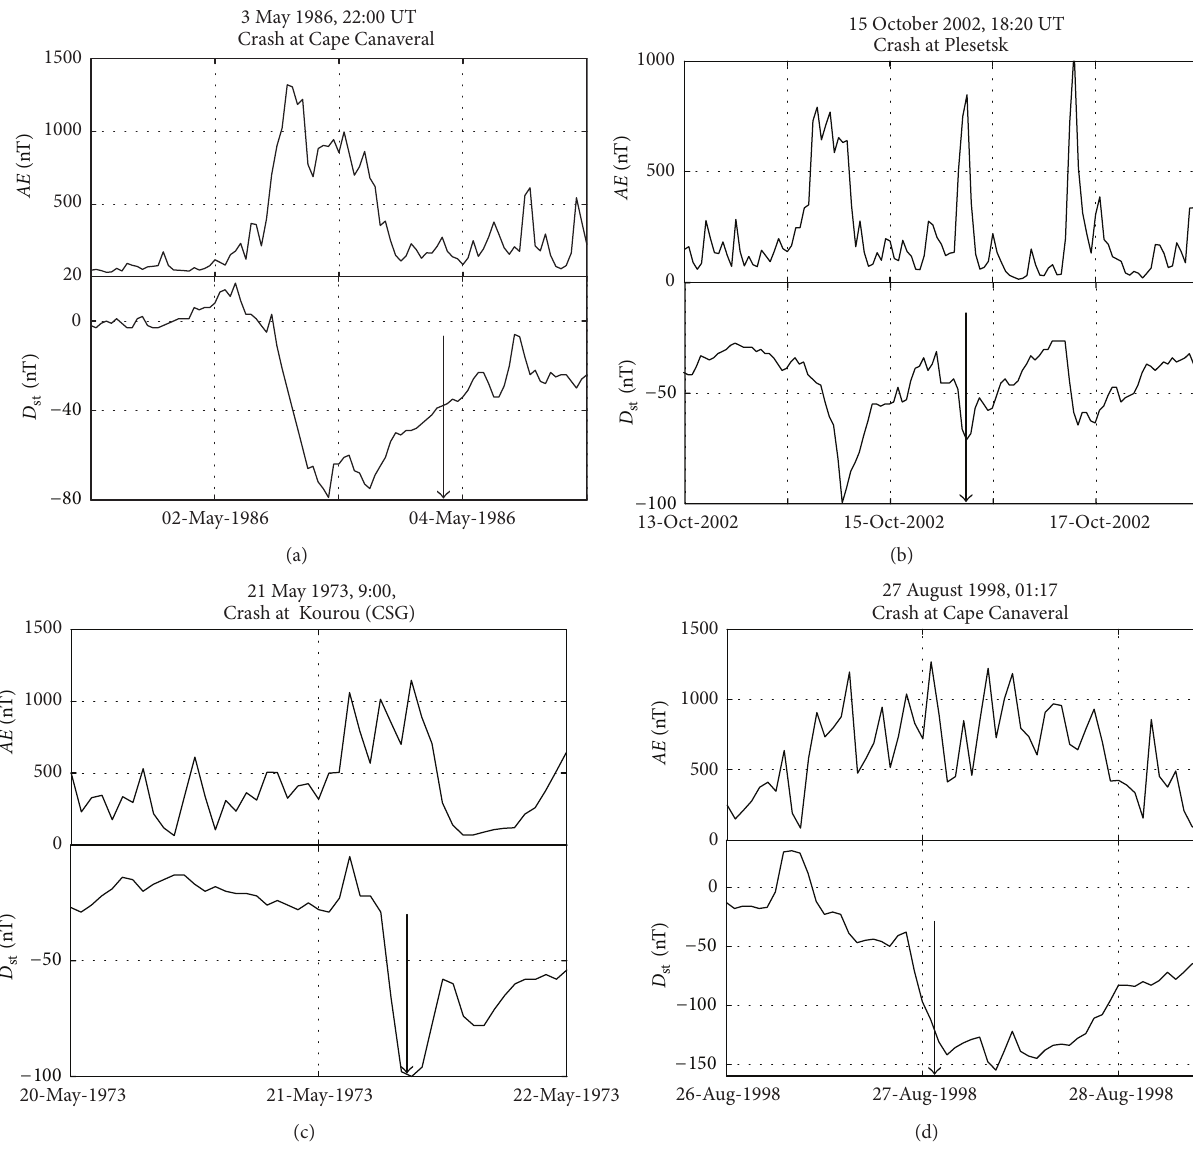
increase turns out to be statistically significant according to the 𝜒 2 -criterion ( 𝑃 = 0.039 , 𝜒 2 = 8.31 ). We are not aware of any reasonable explanation for this